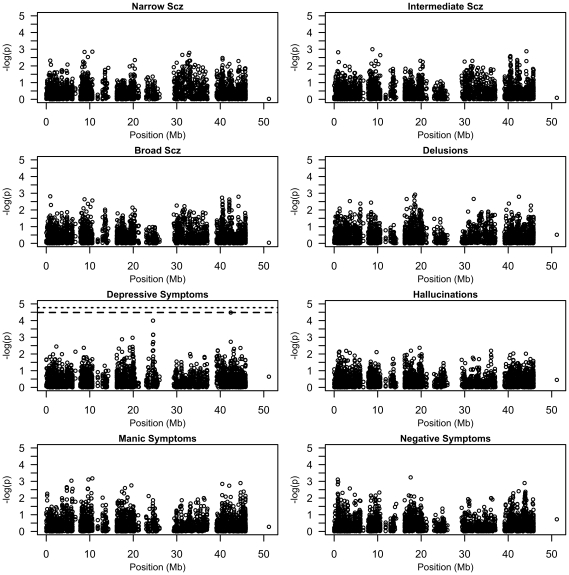
Physical distribution of single-marker associations on chromosome 20, for both categorical diagnoses and clinical dimensions of Scz.Associations are displayed as log-transformed P-values (−log
10
P) at genomic positions in megabases (Mb). Where appropriate, a dotted line indicates the Bonferroni-corrected significance threshold, accounting for number of SNPs assayed experiment-wide. Similarly, a dashed line indicates the LD-corrected significance threshold, as estimated by SNPSpD.